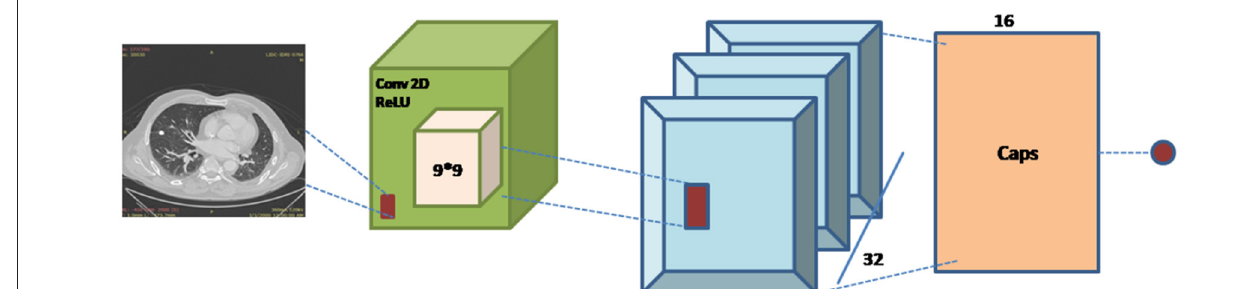
FIGURE 7 | CapsNet architecture.